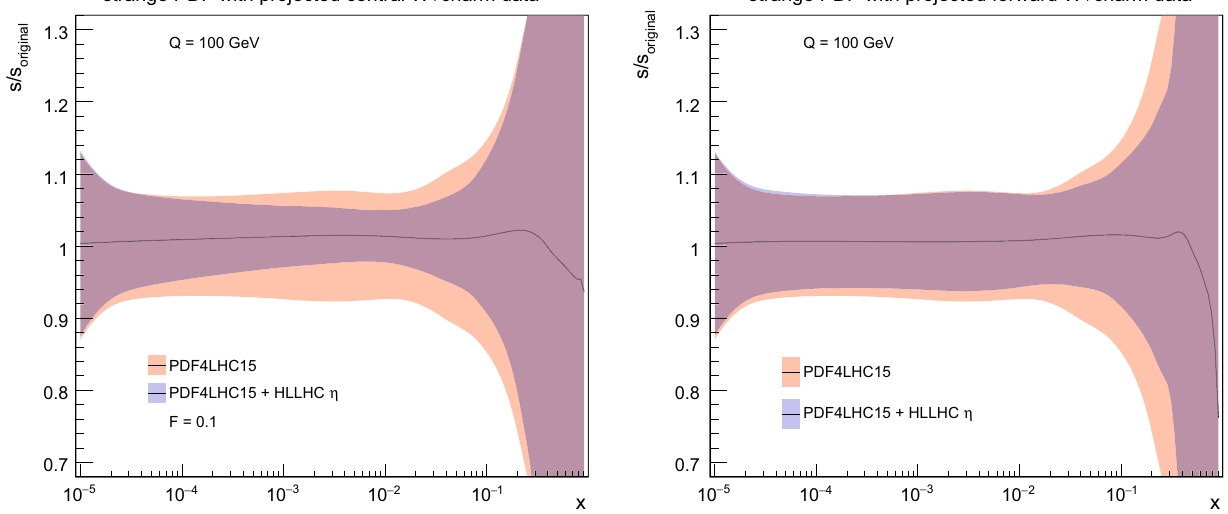
Fig. 14 As in Fig. 6, now for the strange quark PDF including the HL–LHC pseudo–data on W +charm production in the central (left plot) and in the forward region (right plot) Correlations between off peak Z production and the gluon PDF Correlations between on peak Z production and the gluon PDF −1−0.8−0.6−0.4−0.200.20.40.60.81 −1−0.8−0.6−0.4−0.200.20.40.60.81 ll ll PDF4LHC15 + HLLHC p PDF4LHC15 + HLLHC p T T